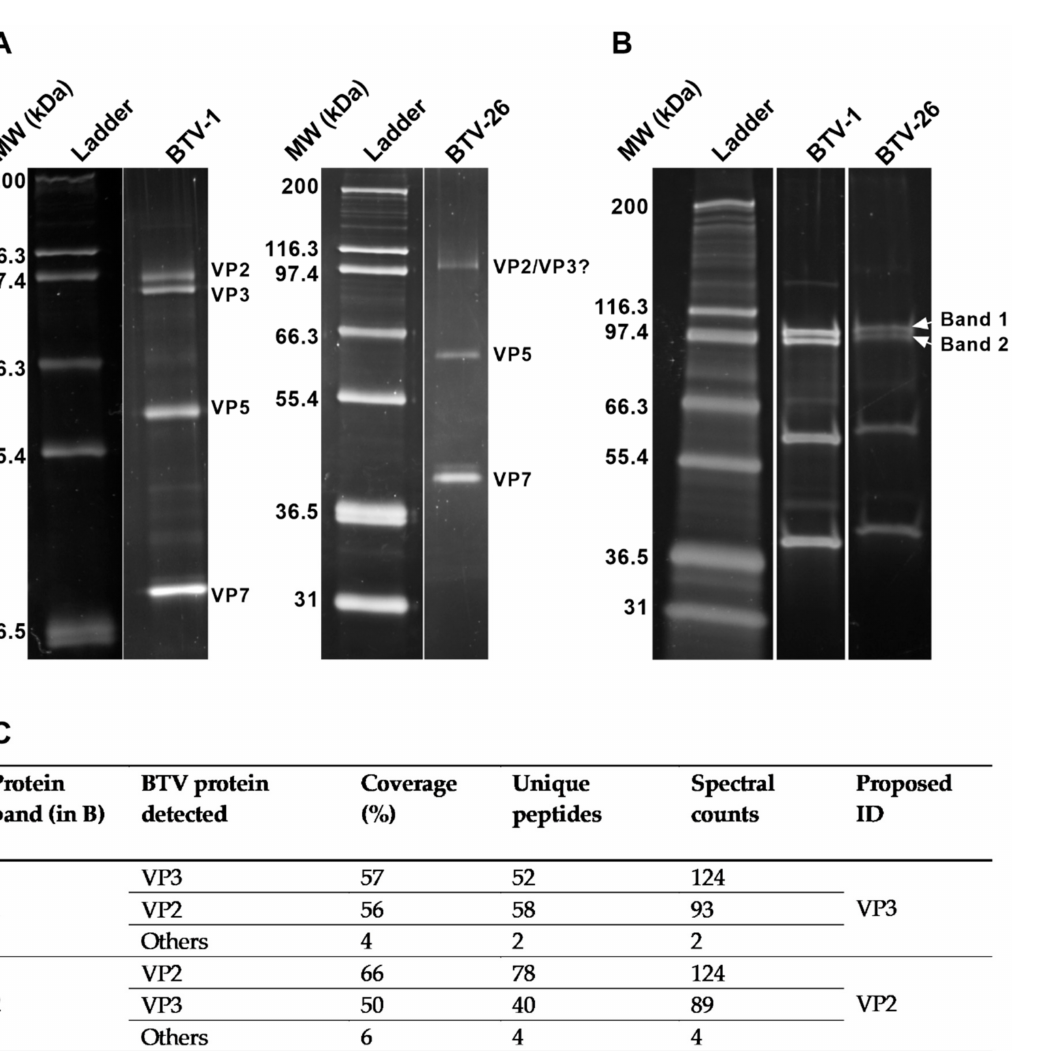
Figure 2. Protein profile of BTV-26 particles and VP2 identification. Purified particles of rBTV-1 and BTV-26 were run in a 10% SDS-PAGE gel ( A ) or a 4%–20% Gradient SDS-PAGE gel ( B ) and stained with SYPRO ® Ruby protein gel stain. BTV particles consists of 3 protein layers: the capsid (VP2 and VP5), the outer core (VP7) and the inner core (VP3). In ( A , B ), ladder is Mark12™ Unstained Standard. Sequencing of Bands 1 and 2 (in B ) by mass-spectrophotometry identified them as BTV-26 VP3 and VP2, respectively ( C